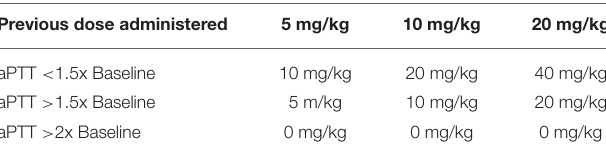
TABLE 1 | This is the dose calculation chart used to calculate dose escalation based on measured aPTT. Previous dose